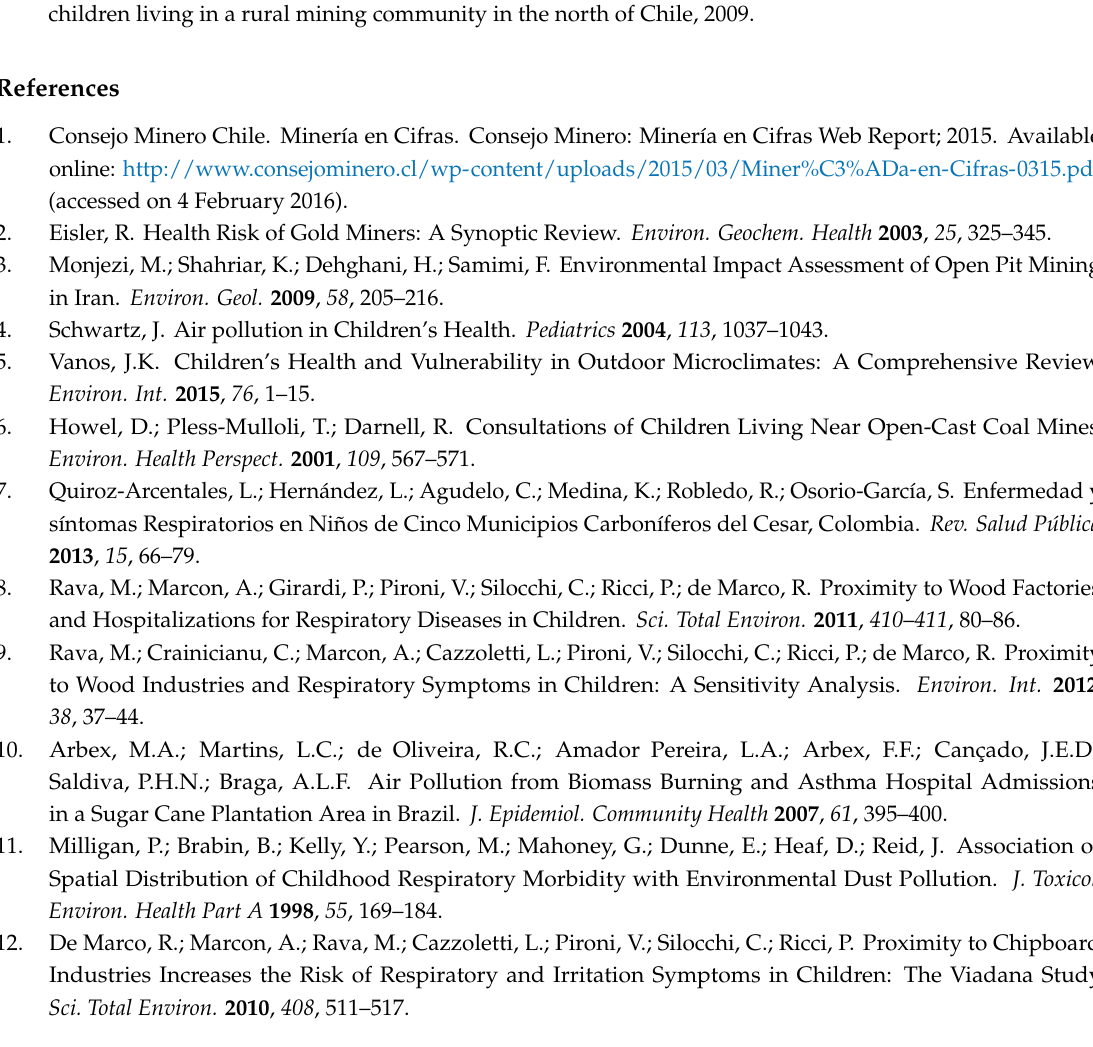
Figure A6. Estimated CAR of asthma or rhinoconjunctivitis in children, expressed as percentage points with whiskers indicate 95% confidence intervals and different distances to the copper mine. Data from children living in a rural mining community in the north of Chile,